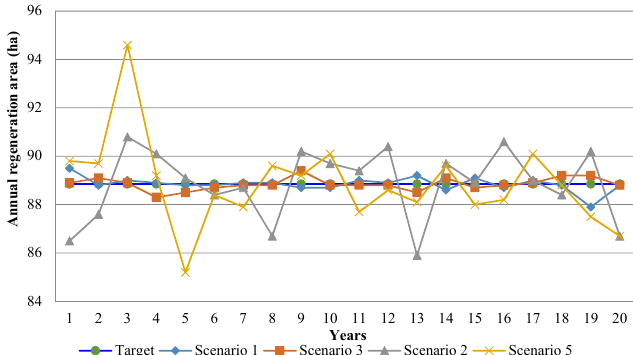
Figure 2. A comparison of the regeneration area achieved using the regeneration model.